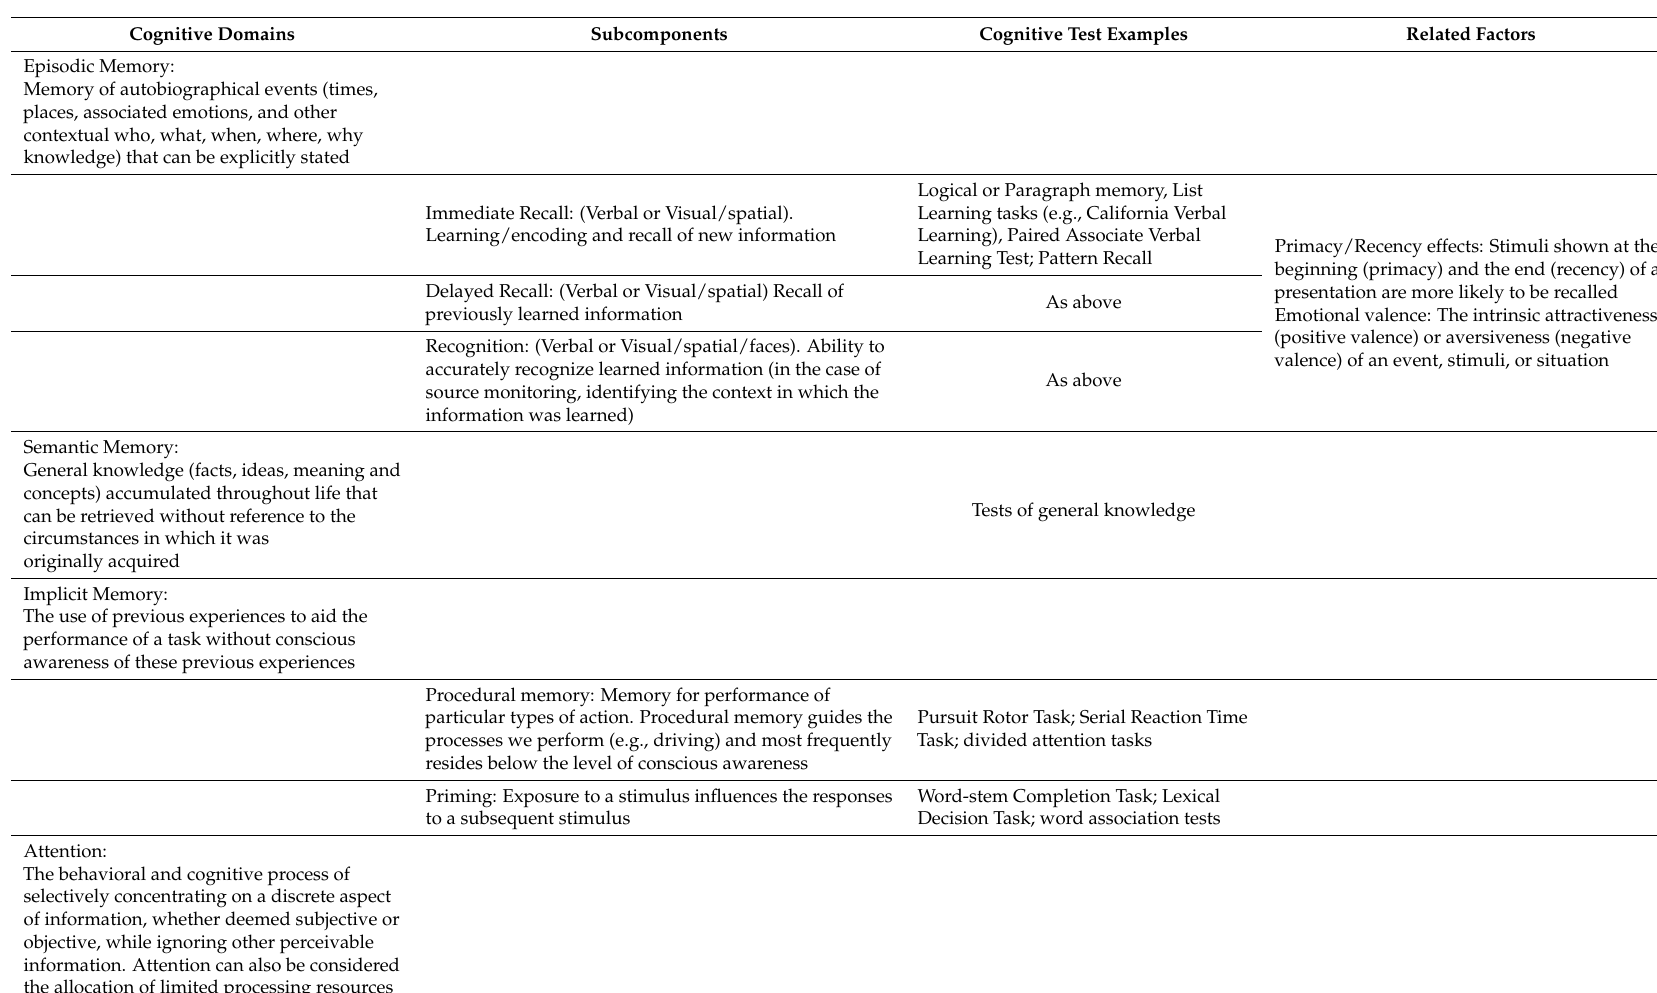
Table 1. Summary of cognitive domains and associated tasks commonly employed in the literature on carbohydrate